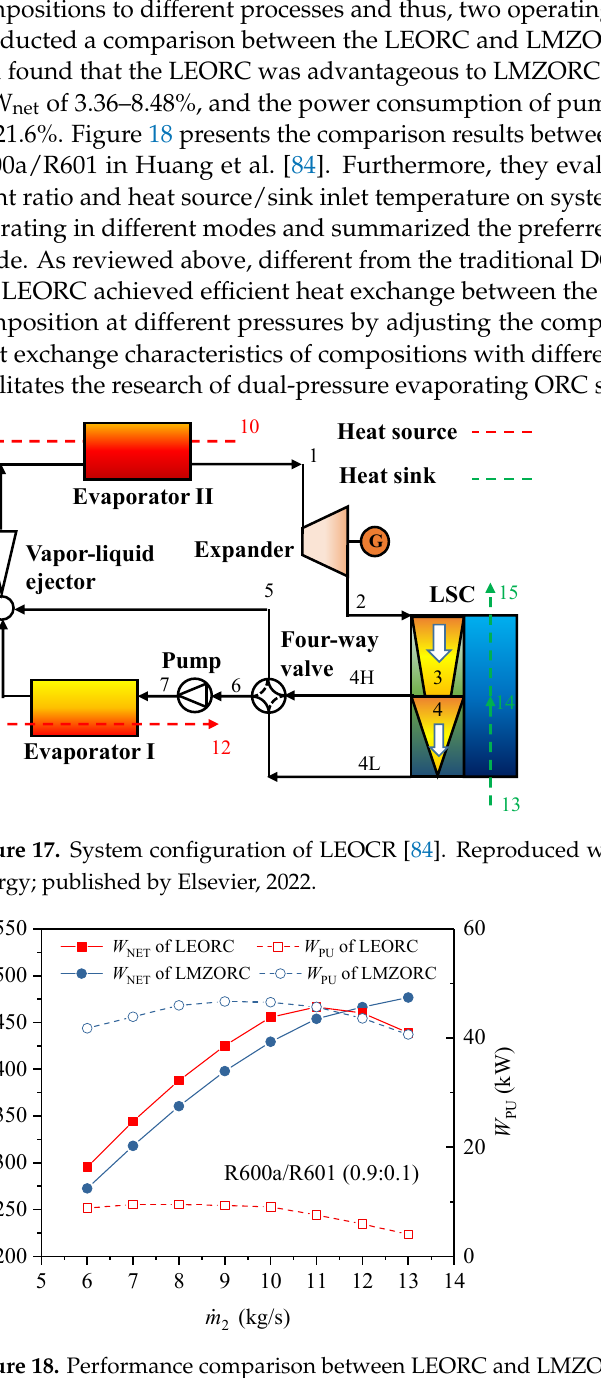
Figure 18. Performance comparison between LEORC and LMZORC [84]. Reproduced with permis- sion from Huang et al., Energy; published by Elsevier, 2022.